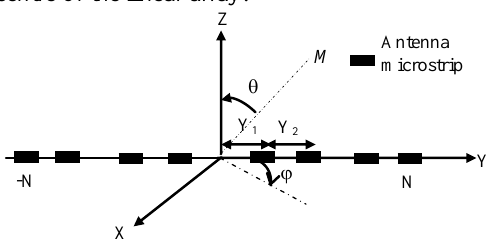
Fig. 1. Geometry of linear array of High superconducting rectangular microstrip antennas